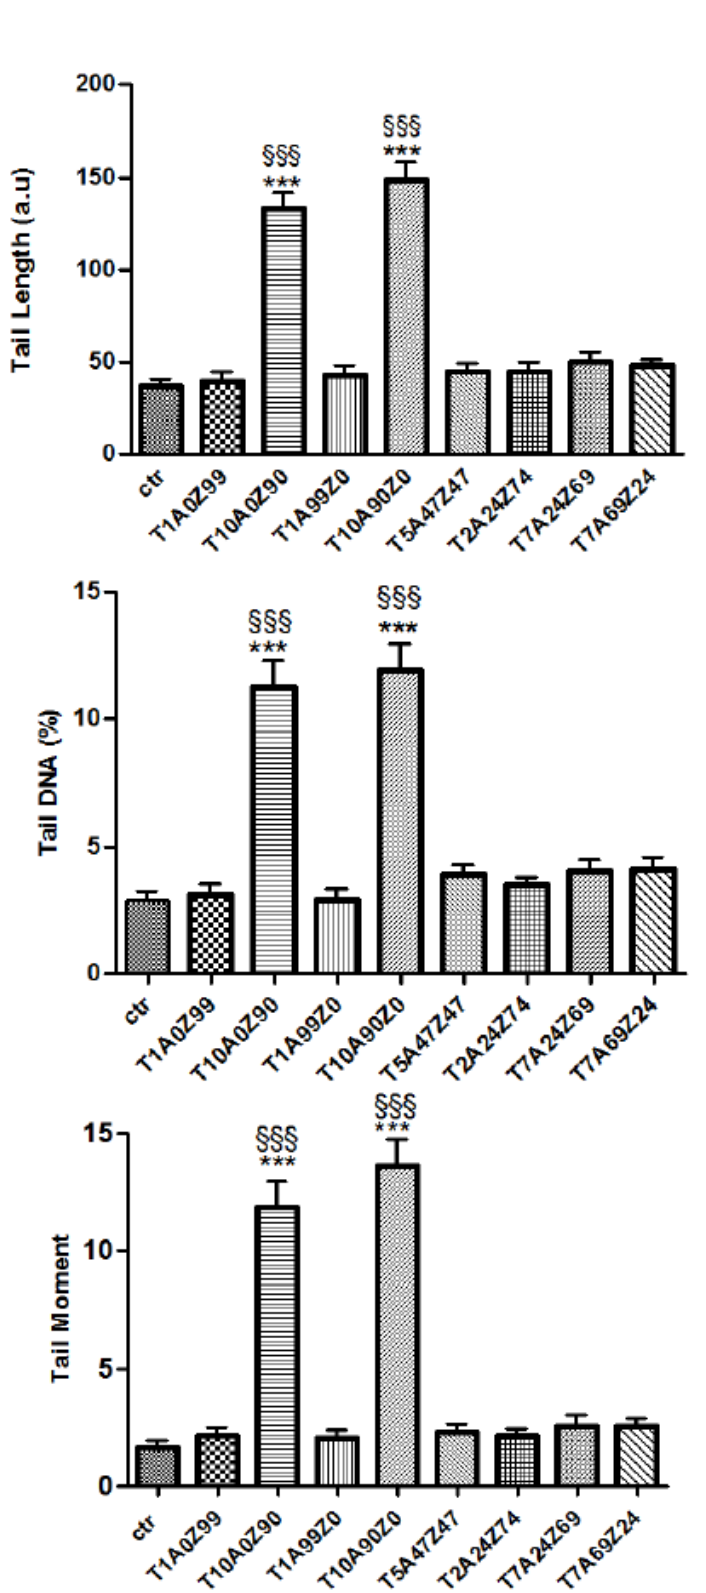
Figure 5. DNA damage analysis of differentiated HGF ‐ 1 cells. ( A ) Representative images of the comet assay performed in the presence or absence of ceramic composites. ( B ) DNA damage was evaluated by measurement of tail length (TL), Tail DNA (%) and tail moment (TM) in CASP software. Values are shown as mean ± standard error of the mean (SEM). *** P < 0.001 in comparison with controls; §§§ P < 0.001 in comparison with cells cultured with different composites.